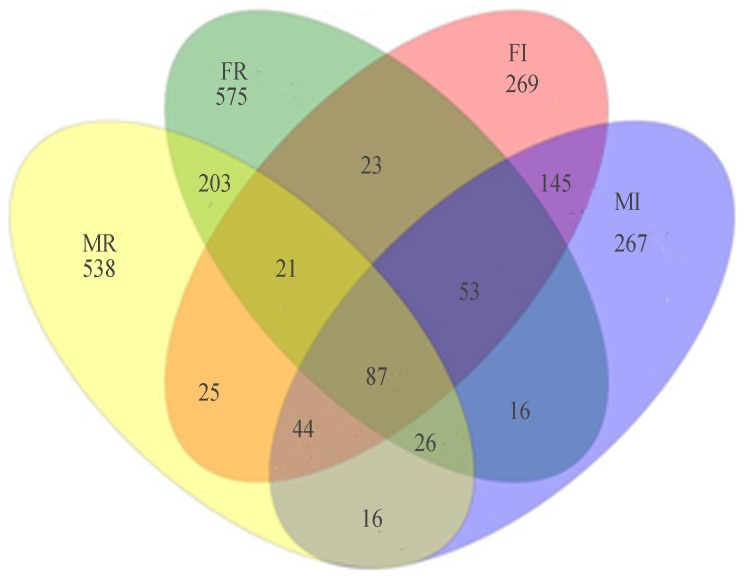
Venn diagram at distance 0.03.The numbers represent the the number of unique species owned by each sample and common species shared by two or more samples. Abbreviations: FI, female-intestine; FR, female-ovary; MI, male-intestine; MR, male-testis.